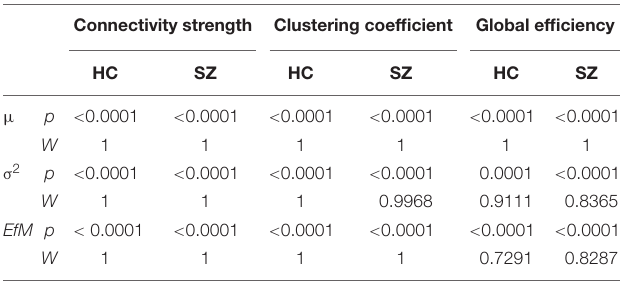
TABLE 2 | Effect of cost on the mean ( µ ), variance ( σ 2 ), and excursions from median (EfM) of dynamic network theoretical measures. Connectivity strength Clustering coefficient Global